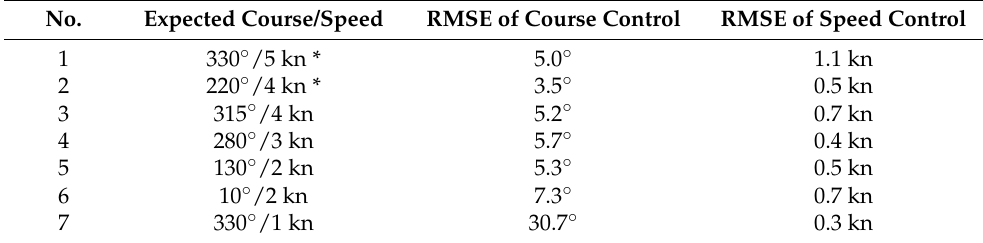
Table 1. RMSE of course and speed coupled control during the sea experiments. No.